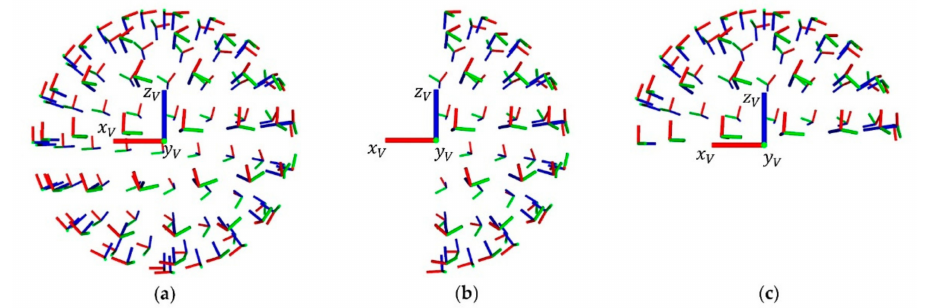
Figure 14. Sets of 6D end-e ff ector poses to calculate reachability and maneuverability. ( a ) full sphere; ( b ) hemisphere pointing in forward x-direction; ( c ) hemisphere pointing in downward z-direction.